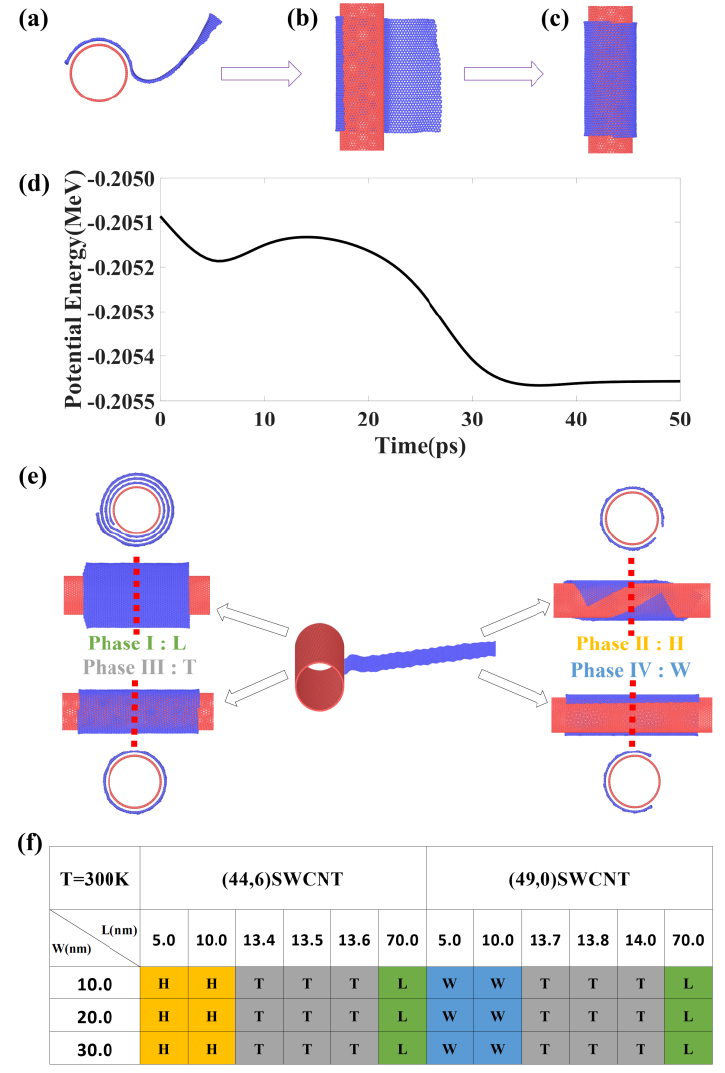
Figure 1. ( a – c ) Self-assembly of a graphene nanoribbon on the (44,6) SWCNT, the size of the GNR is 13.6 nm × 10.0 nm. ( d ) Corresponding potential energy variation. ( e ) Representative phases obtained from MD simulations. ( f ) Summarized phase diagram for the assembly associated with the size of the GNR.